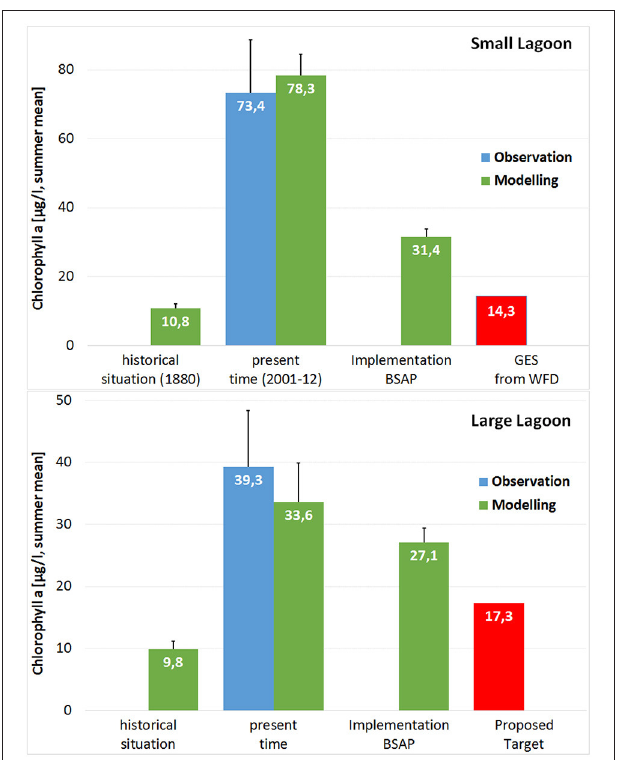
FIGURE 7 | Mean values of summer Chl-a in Small and Large Lagoon based on observations (blue) and model simulations (green), supplemented by threshold concentration for GES (red) at Small Lagoon and the proposed threshold for Large Lagoon.